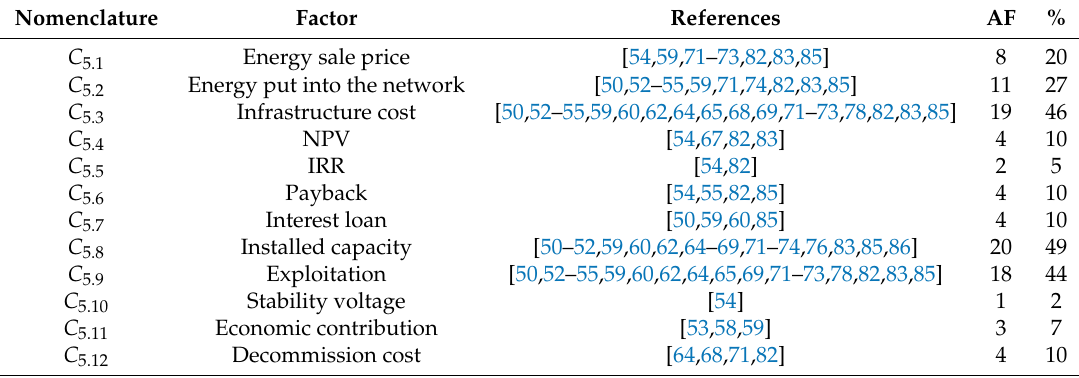
Table 17. Economics Category ( C 5 )—Offshore wind energy. Quantitative analysis.